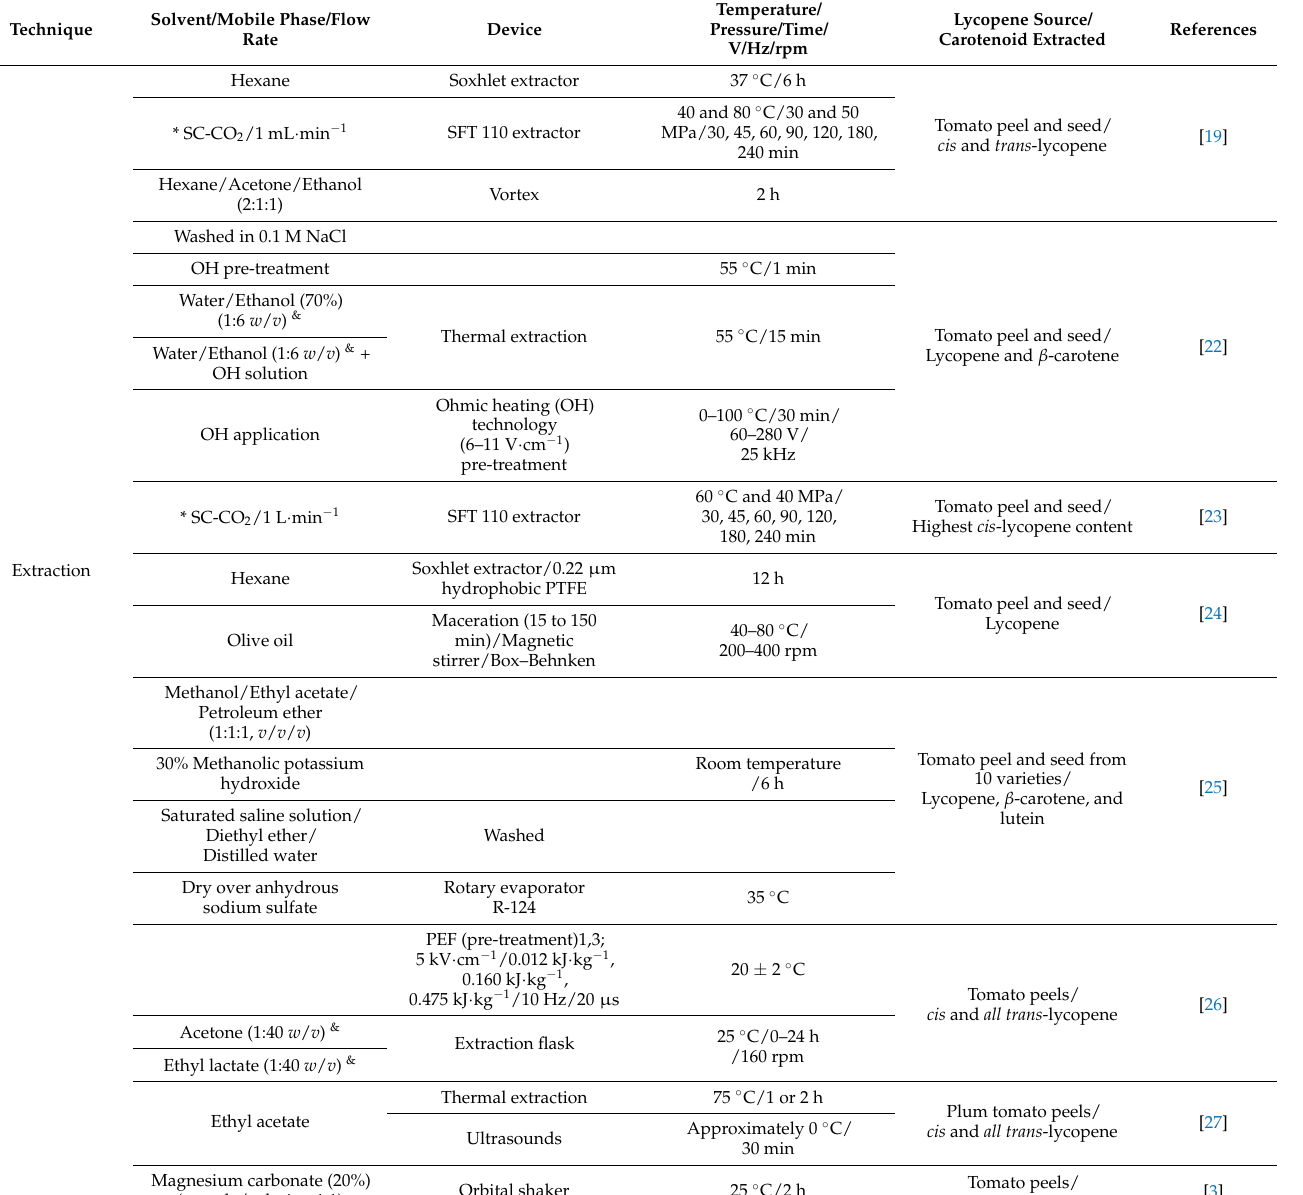
Table 1. Type of lycopene obtained from different extraction methods and biosynthesis from 2017 to